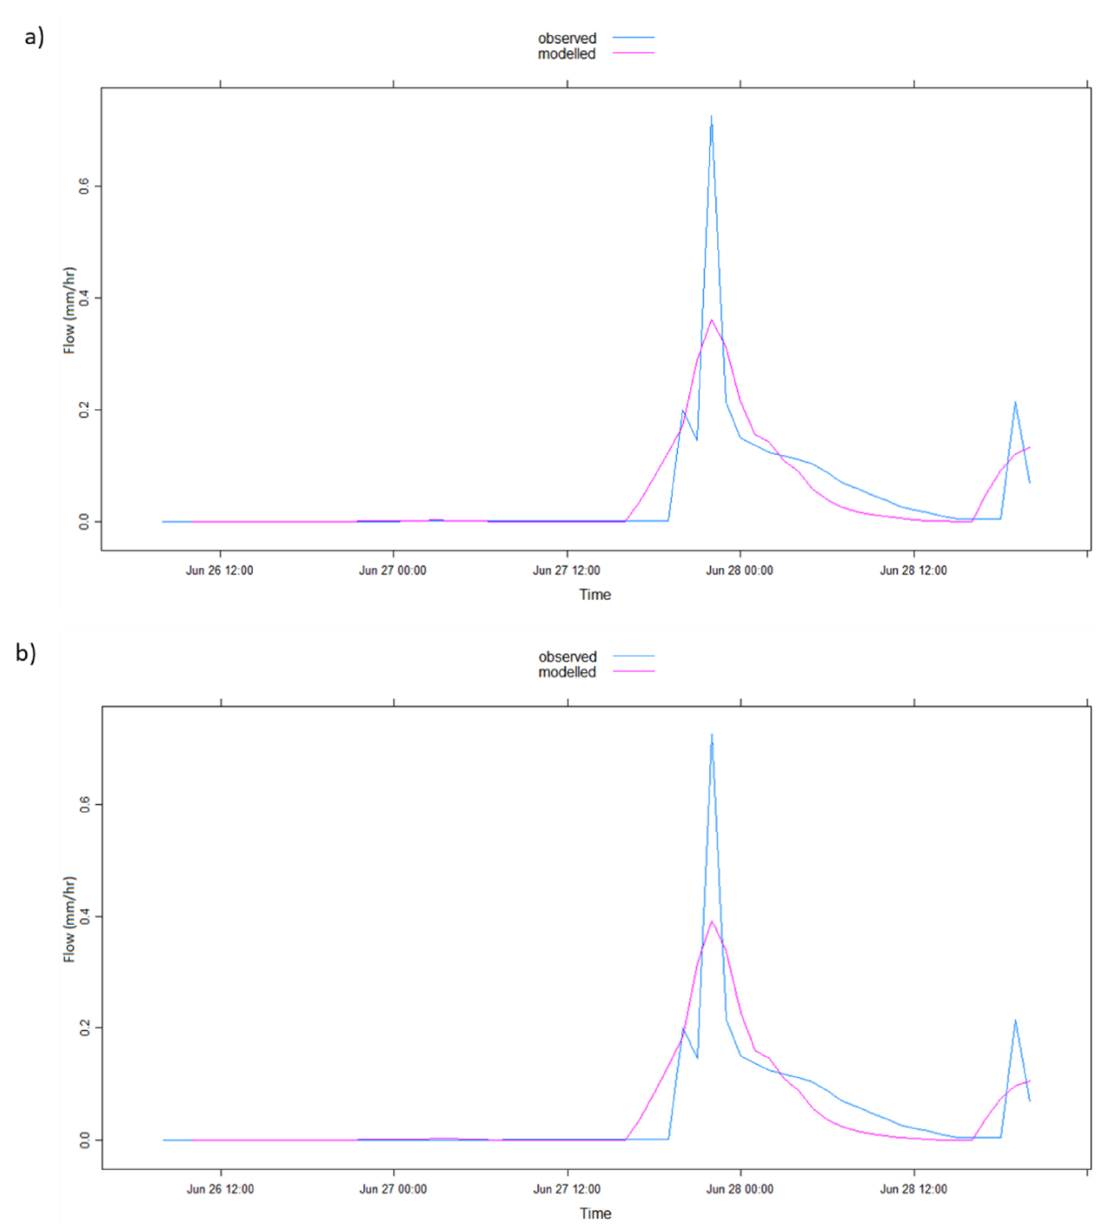
Figure 6. IHACRES model simulation results with ( a ) rsq_daily and ( b ) rsq_hourly objective functions for the 2002b flood event.